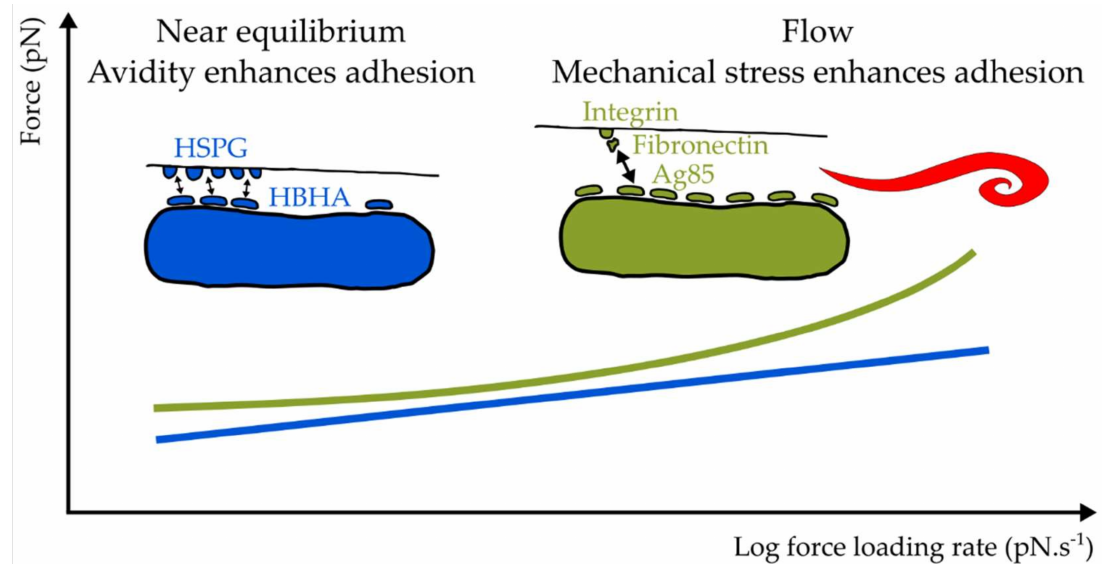
Figure 4. Mechanical stress enhances Antigen 85 (Ag85) binding to fibronectin, a possible mechanism to enhance adhesion in dynamic environments such as the circulatory system or in the gastrointesti- nal tract. On the other hand, HBHA binding HSPG receptors on alveolar epithelial cells follows conventional forced unbinding kinetics. In this case, adhesion is enhanced through HBHA clustering allowing multiple parallel interactions with